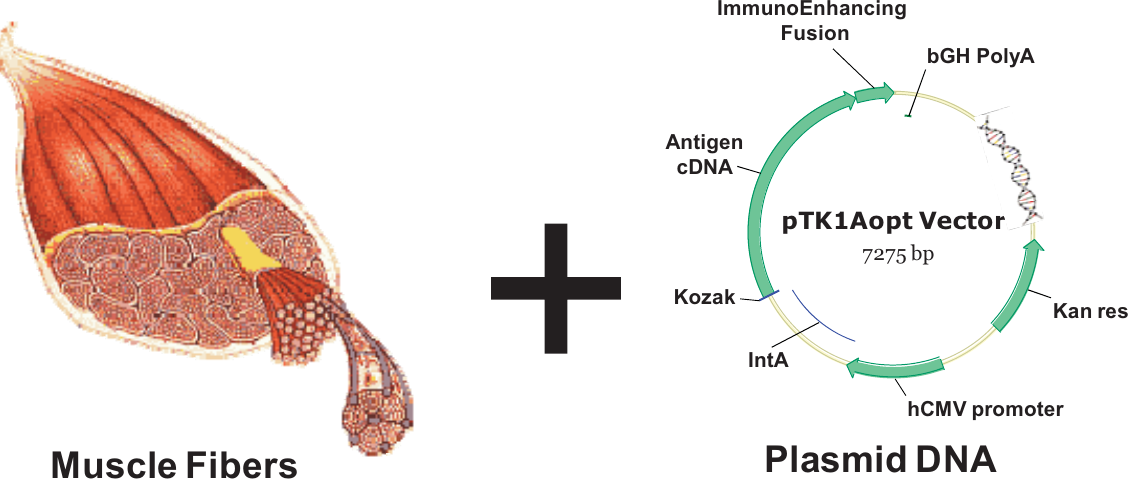
Figure 3. Intramuscular delivery of a DNA vaccine: in the right panel of the figure is a schematic representation of a standard expression vector used for DNA vaccines bearing an expression cassette driven by the Cytomegalovirus Intron A (CMV-IntA) promoter. The antigen cDNA can be engineered and fused to an immunoenhancing moiety. Muscle cells (left) are the major target for expression of the antigen of